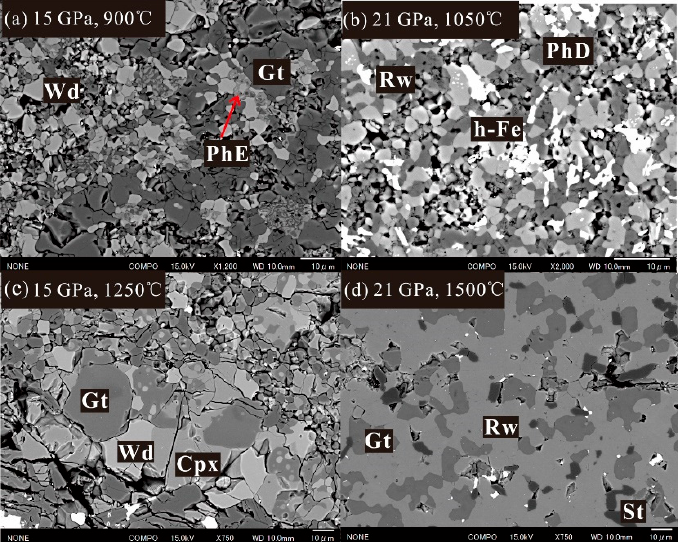
Figure 2. Backscattered electron images of representative run products under various pressure and temperature conditions: ( a ) 15 GPa and 900 °C; ( b ) 21 GPa and 1050 °C; ( c ) 15 GPa and 1250 °C; ( d ) 21 GPa and 1500 °C. Gt, garnet; Cpx, clinopyroxene; Wd, wadsleyite; Rw, ringwoodite; St, stishovite; PhE, phase E; PhD, phase D; h-Fe, iron-rich hydrous phase. ◦ Cpx was observed at 16.5 GPa and 1300 C, which further transformed to Gt at higher pressures. ◦ Stishovite (St) was found to be coexisting with Rw at temperatures higher than 1100 C. Some amount ◦ ◦ of ferrous oxide was detected at 21 GPa and 1050 C. At 21 GPa and 1000 C, we found iron-rich hydrous phase, based on analyzing the deficit of weight total. Both, the total weight and di ff raction pattern, were similar to ε FeOOH; however, the di ff raction peaks were slightly shifted compared with ε FeOOH, probably because of the incorporation of Mg due to the similar ionic radius of VI Mg 2 + (0.72